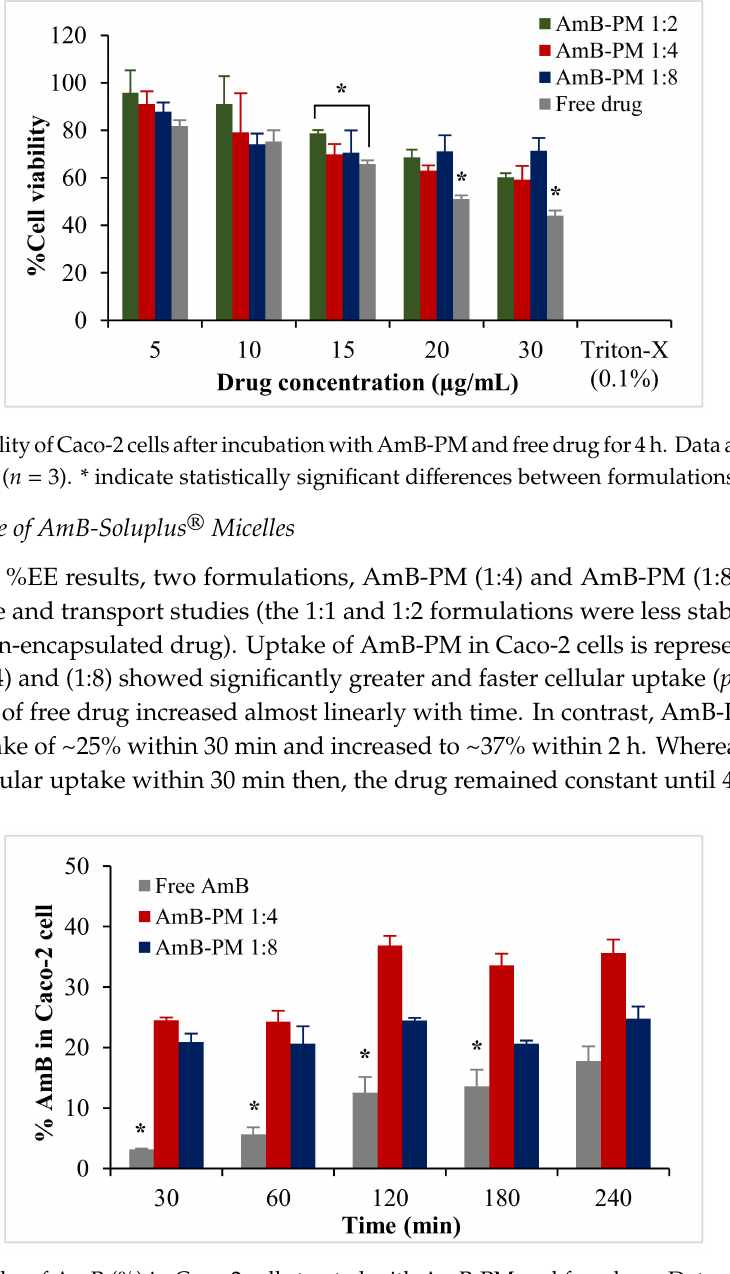
Figure 5. Uptake of AmB (%) in Caco-2 cells treated with AmB-PM and free drug. Data are presented as mean ± SD, ( n = 3). * indicate statistically significant di ff erences between formulations ( p <